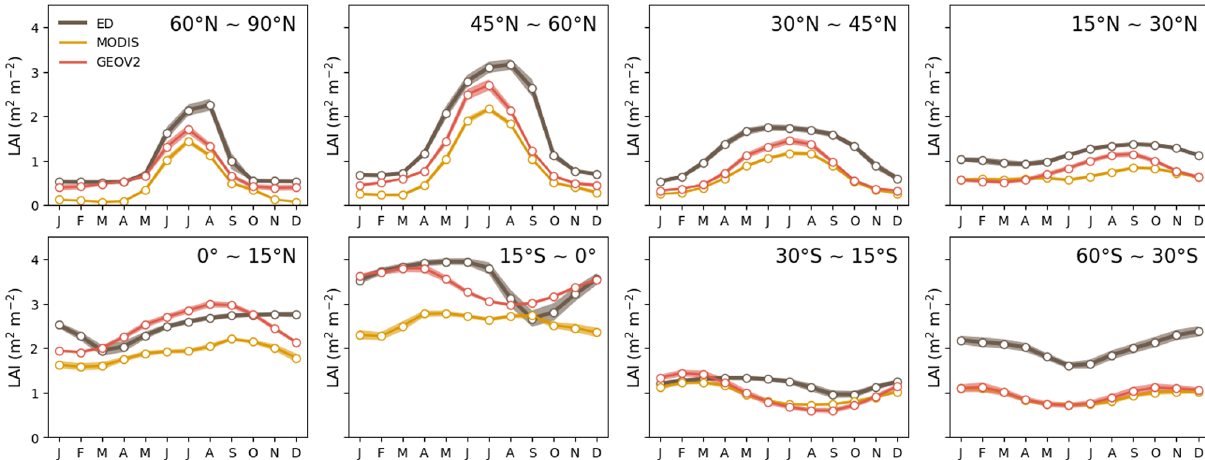
Figure 14. Seasonal LAI by latitudinal band from ED, MODIS and GEOV2.